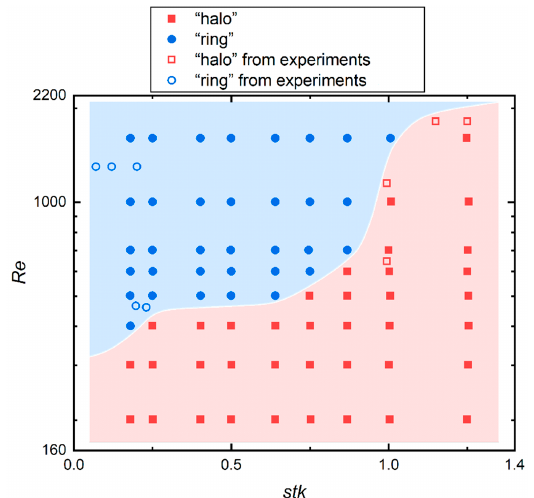
Figure 11. Categorization of the “halo” and “ring” deposit in terms of the value of Re and stk . The solid points and hollow points were taken from the simulation and experiment results [4,7,10–12],